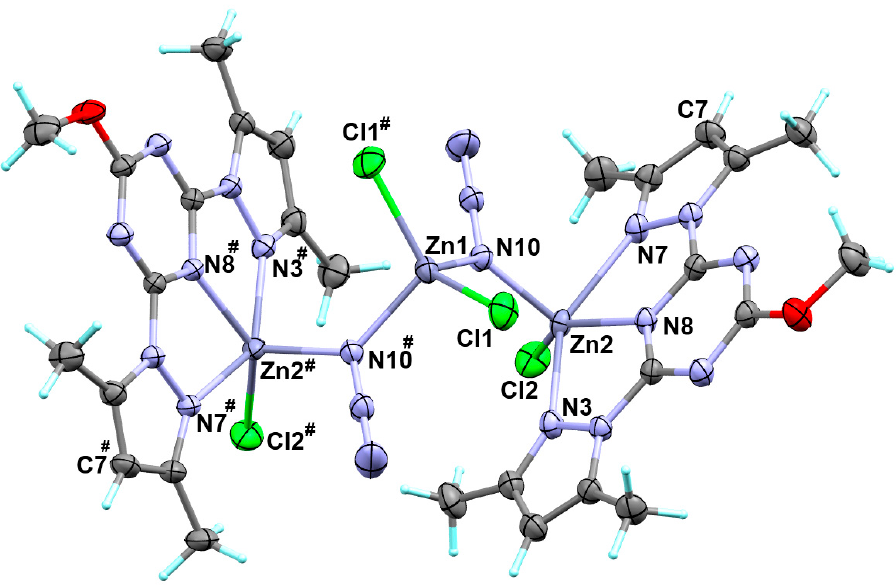
Figure 2. The X-ray structure of the [Zn 3 (PMT) 2 (Cl 4 )(N 3 ) 2 ] complex. Symmetry code: # − x,y,1/2 − z. In this trinuclear complex, there was a two-fold rotation axis passing through the Zn(1) site. Hence, the asymmetric formula contained one half of the [Zn 3 (PMT) 2 (Cl 4 )(N 3 ) 2 ] complex formula. As a result, the trinuclear Zn(II) complex comprised two halves of the asymmetric formula, shown in the right part of Figure 2. It is clear that there were two crystallographically independent Zn(II) sites, which differed completely in the coordination environment. The Zn(1) site was tetra-coordinated and had a complete inorganic coordination environment with two chloride and two azide ions as ligands. Due to symmetry consideration, the two Zn1–Cl1 bonds were equidistant (2.2305(12) Å). In addition, the same was true for the Zn1–N10 bonds (2.040(2) Å). The bond angles for the coordination environment around the Zn(1) site ranged from 105.46(8)° to 118.35(7)° for the N10– Zn1–Cl1 # and Cl1–Zn1–Cl1 # , respectively (Table 2). Since the distances between the Zn(1)